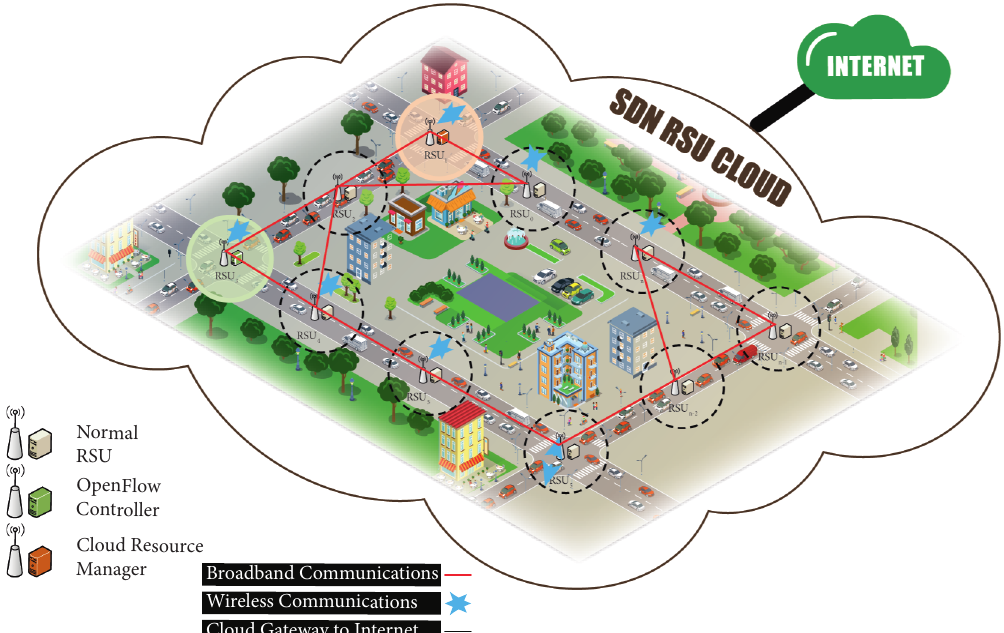
Figure 1: System architecture of the proposed SDN RSU